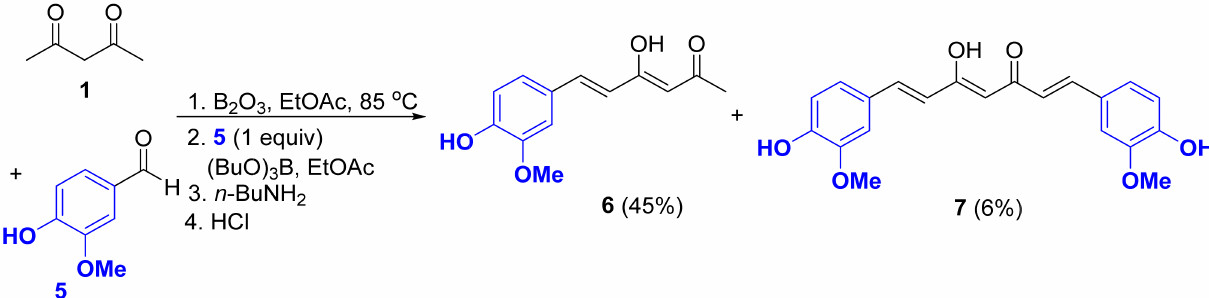
Scheme 1. Pabon’s method for the synthesis of monosubstituted intermediate 6 .